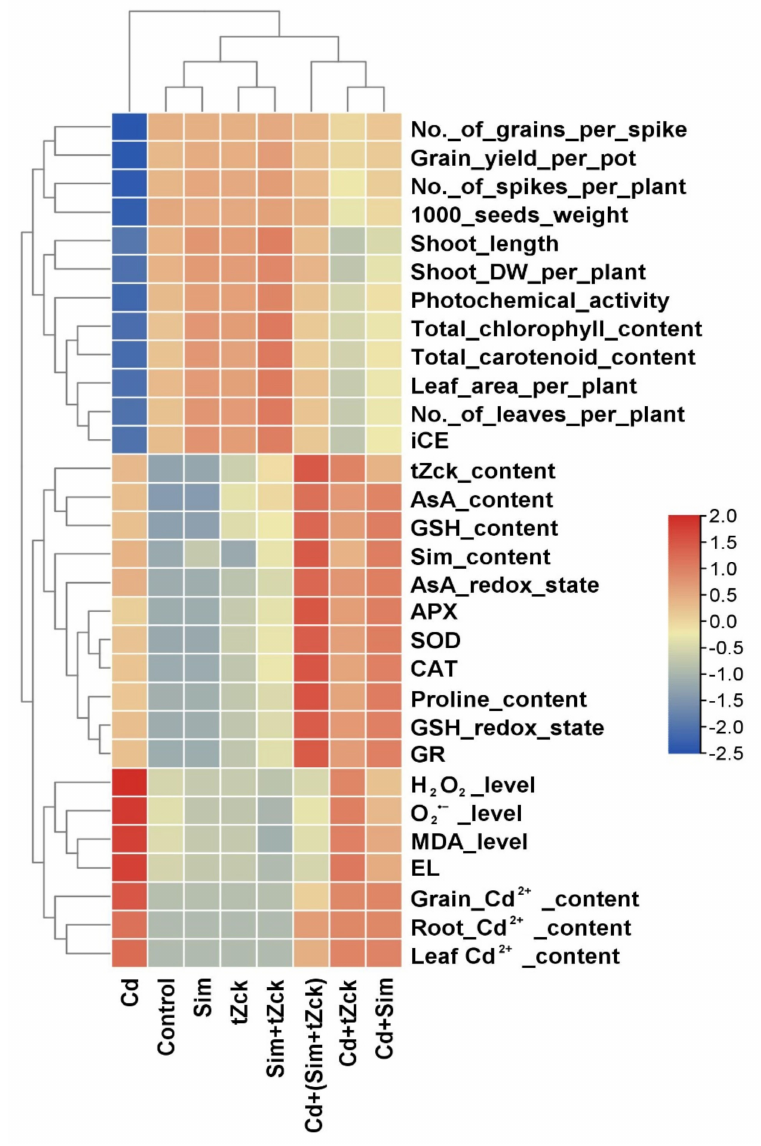
Figure 9. Heatmap graph shows the analysis of hierarchical clustering among the different studied treatments and parameters. The colors represent variations in the obtained data. iCE; instantaneous carboxylation efficiency, O 2 •− ; superoxide, H 2 O 2; hydrogen peroxide level, MDA; malondialdehyde level, EL; electrolyte leakage, Cd; cadmium content, AsA; ascorbate level, GSH; glutathione, Sim; Silymarin, t Zck; trans -zeatin-type cytokinin contents, SOD; superoxide dismutase, CAT; catalase, APX; ascorbate peroxidase and GR; glutathione reductase. Pearson’s correlation analysis declared a significant positive correlation ( p ≤ 0.05) between total carotenoid content, photochemical activity, iCE, shoot dry weight, leaf area, total chlorophyll content, plant leaf no. and shoot length with the grain yield, plant grain no., plant spike no. and 1000-seed weight. O 2 •− , H 2 O 2 , MDA, EL levels, leaf Cd 2+ , root Cd 2+, and grain Cd 2+ contents had a negative (significant) correlation ( p ≤ 0.05) with the above-mentioned traits (Figure 10). Moreover, a positive correlation ( p ≤ 0.05) was found between states of ASA redox, GSH redox, and APX, CAT, SOD, and GR activities with t Zck, Sim, ASA, and GSH